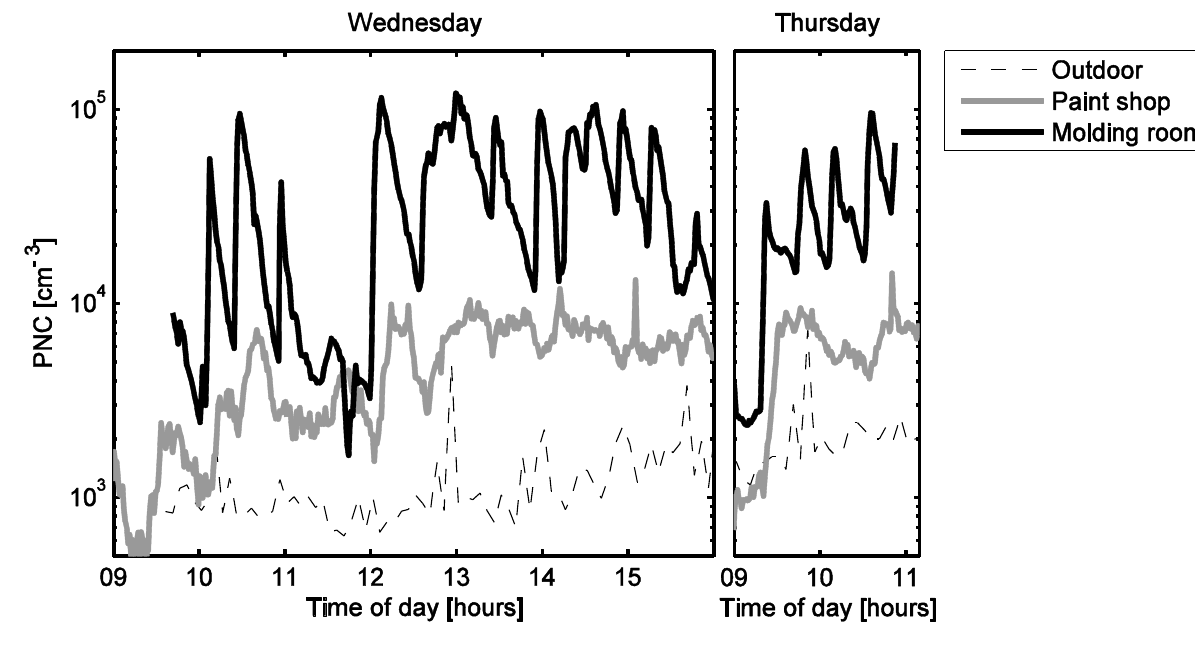
Figure 5. Particle number concentrations in the molding room, in the paint shop, and